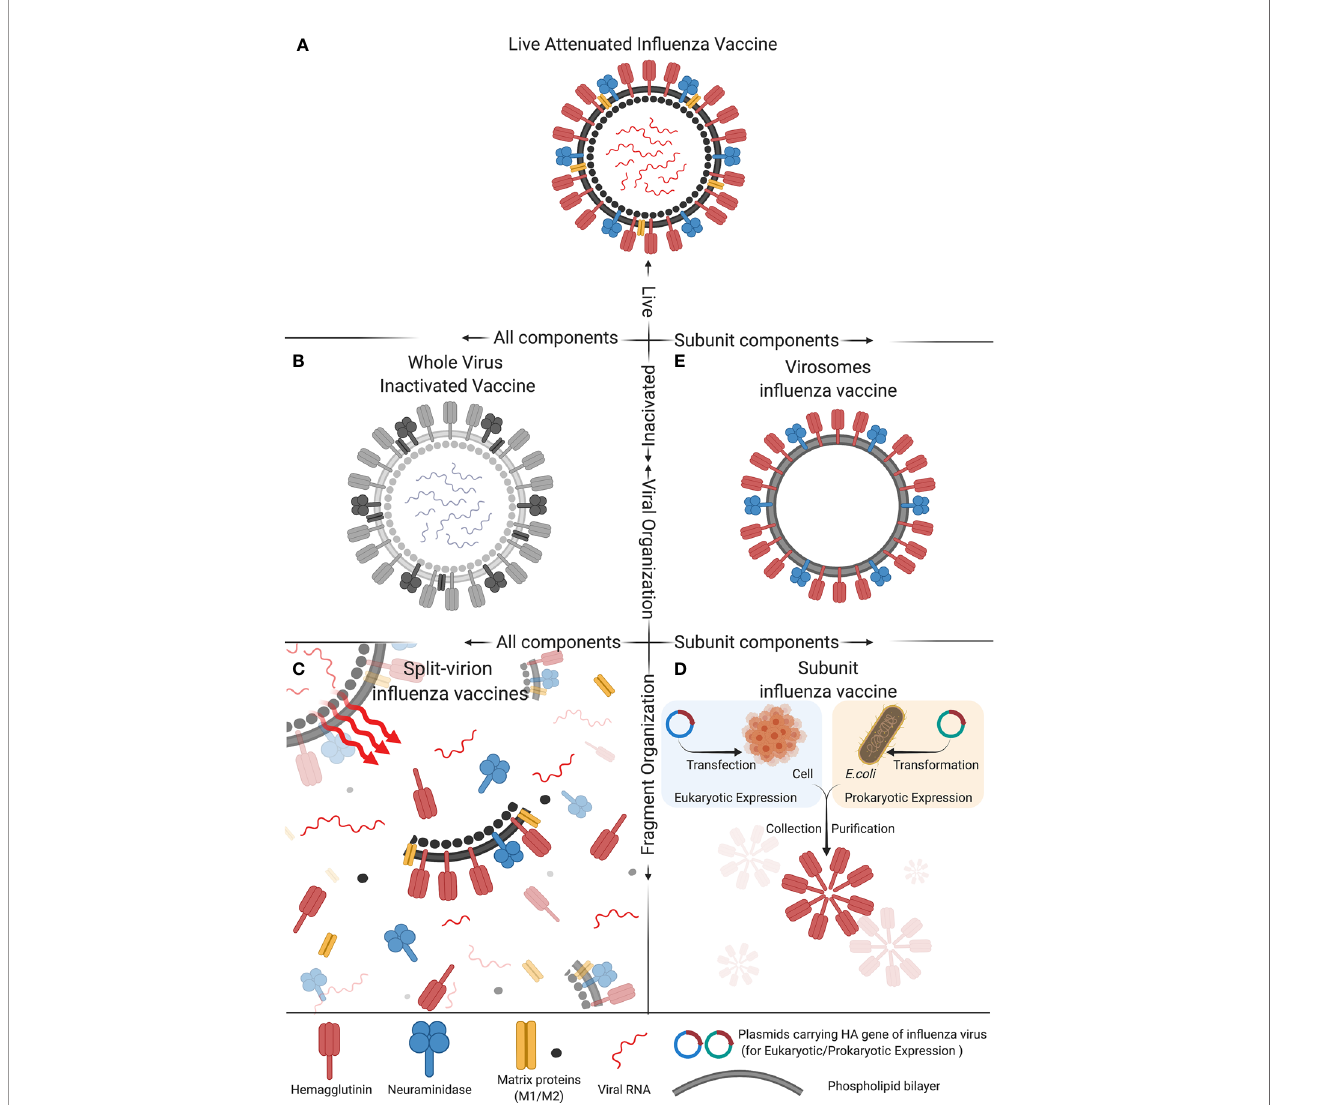
FIGURE 1 | Composition of fi ve types of commonly used in fl uenza vaccines: (A) Live attenuated in fl uenza vaccine, (B) Whole virus inactivated vaccine, (C) Spit- virion in fl uenza vaccine, (D) Subunit in fl uenza vaccine, and (E) Virosomes in fl uenza vaccine. These fi ve different compositions of in fl uenza vaccine differ in activity, antigen components and structural organization, which impact the immunogenicity and protective ef fi cacy of the vaccine. The fi gure was created with